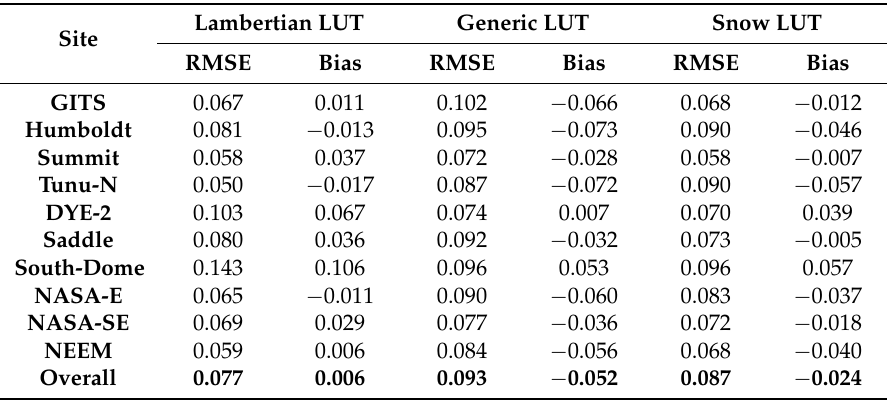
Figure 5. Relationship between the solar zenith angle and the absolute difference of VIIRS albedo retrieval (|estimation-ground truth|) for ( a ) Lambertian LUT; and ( b ) snow-specific BRDF LUT. Table 3. Summary of ground validation results over 10 snow sites.